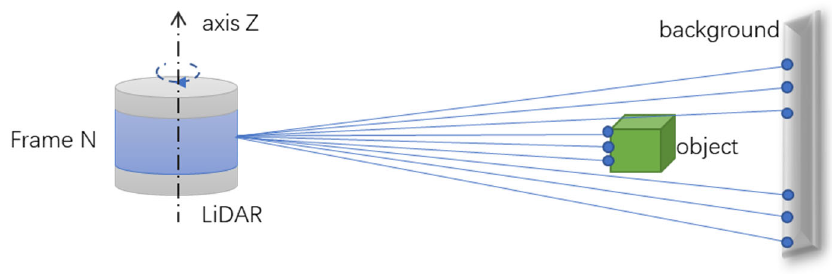
Figure 2. LiDAR targeting an object at a certain moment.